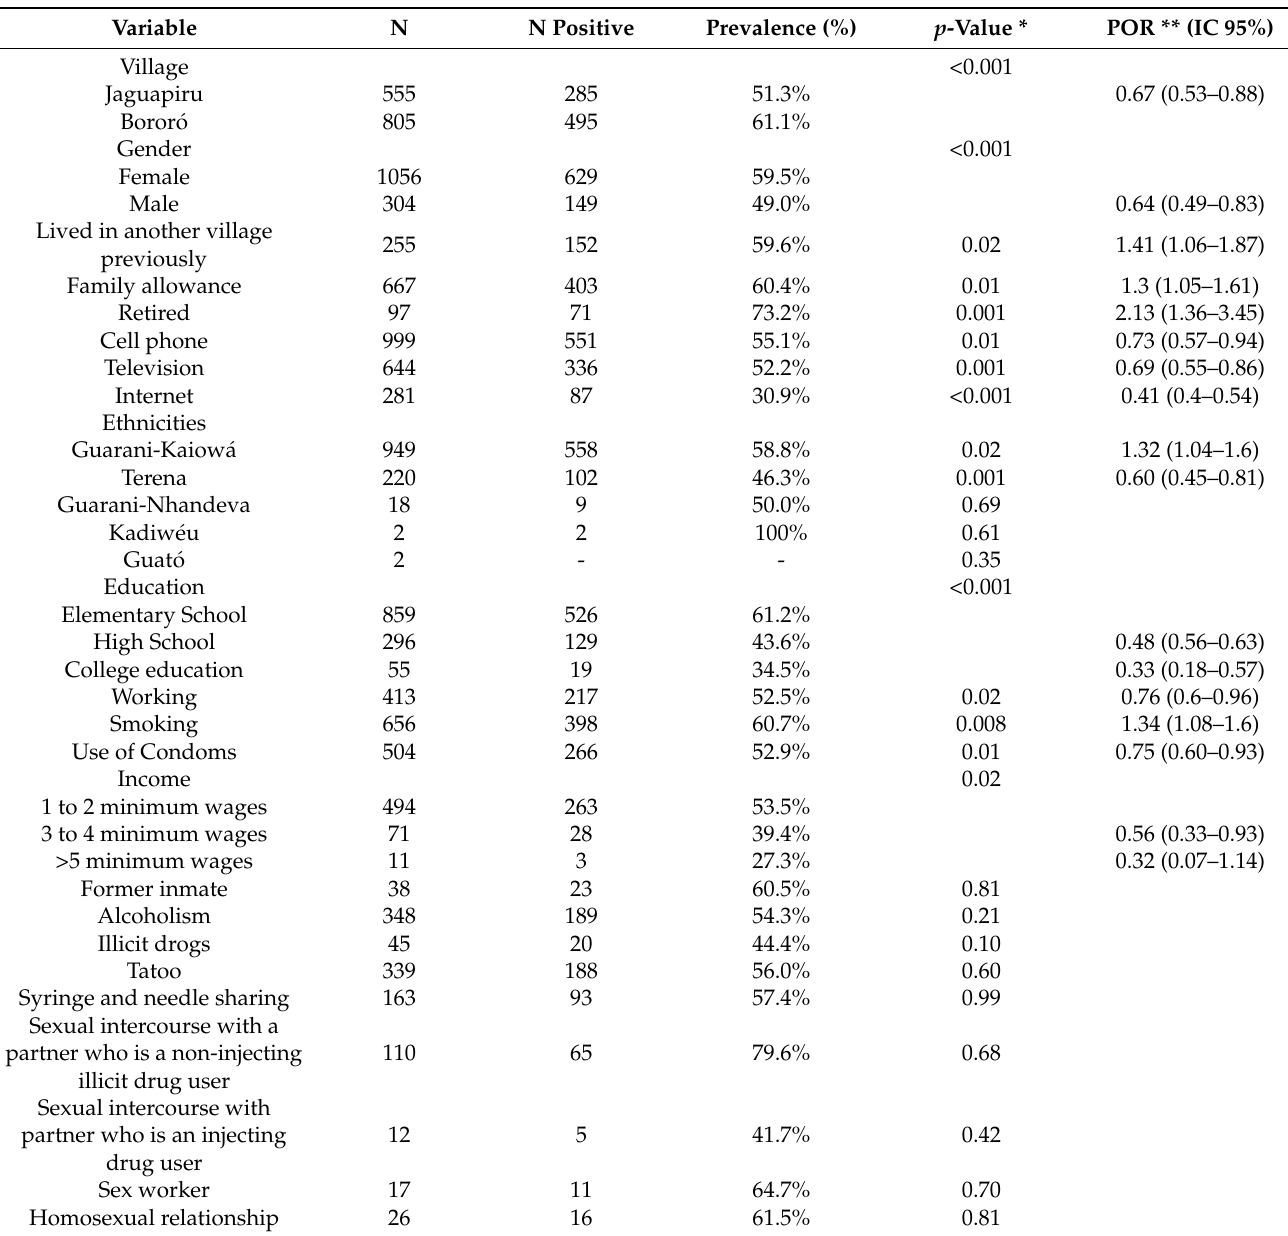
Figure 1 plots the distribution of HSV-2 positivity vs. age, where in the mean age of infection was 40.6 years with a concentration of HSV-2 prevalence around 29 and 39 years. Table 1. Comparison of different variables associated with anti-HSV-2 IgG prevalence among Indige- nous communities in Boror ó and Jaguapir ú villages (Dourados, Mato Grosso do Sul (MS),